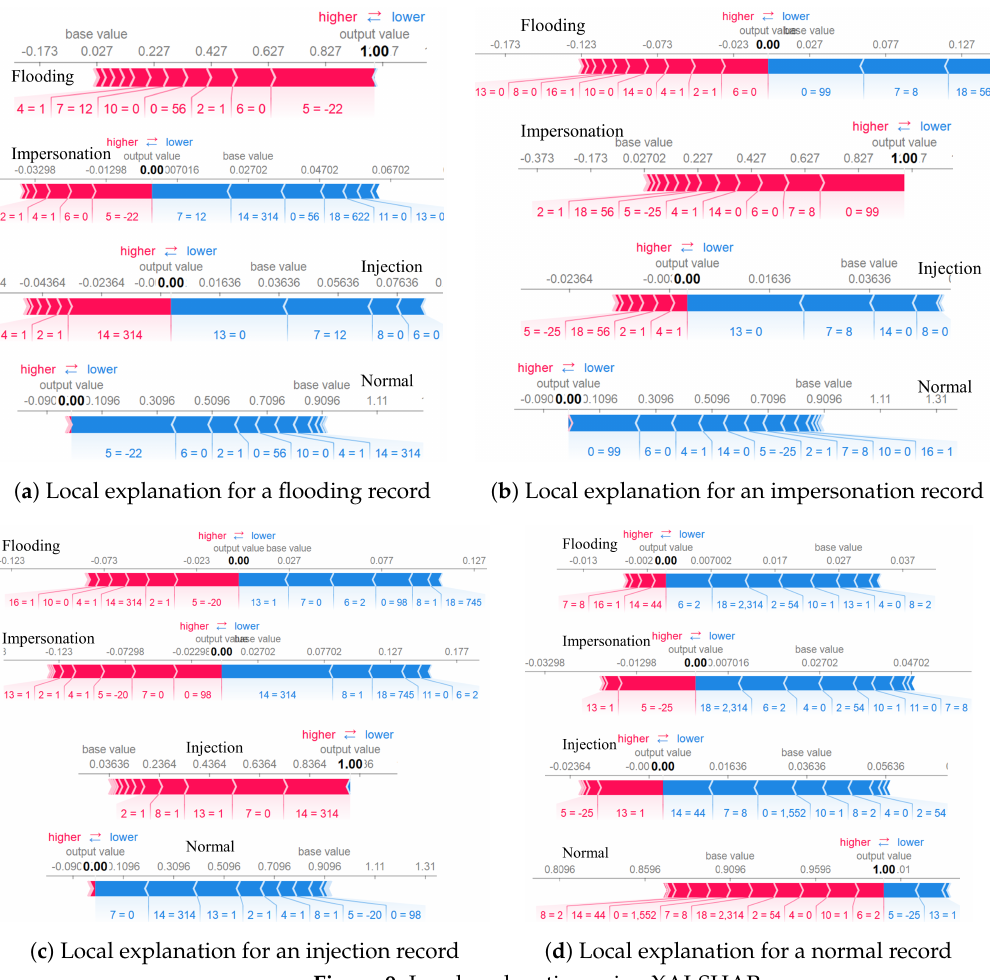
Figure 9. Local explanation using